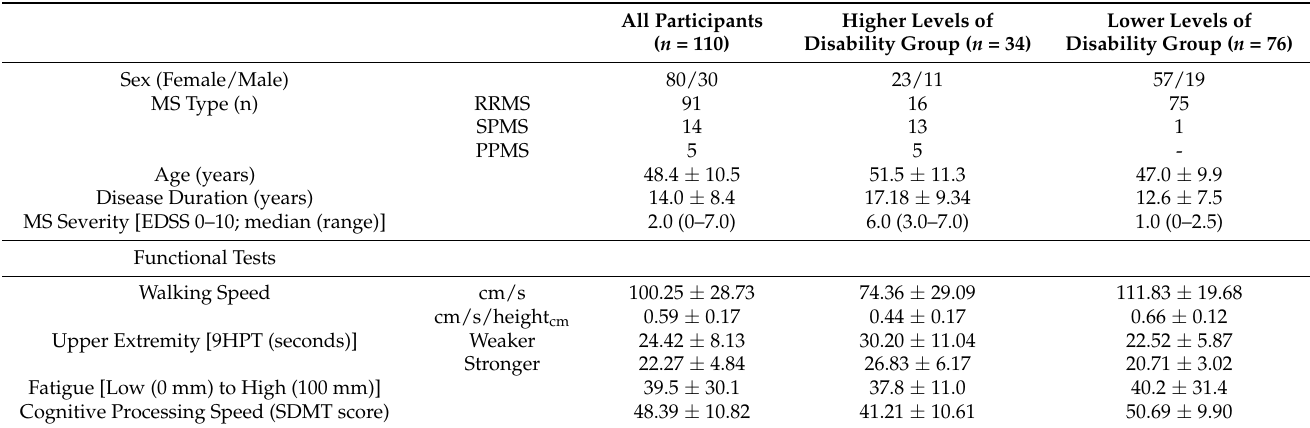
Table 1. Participants’